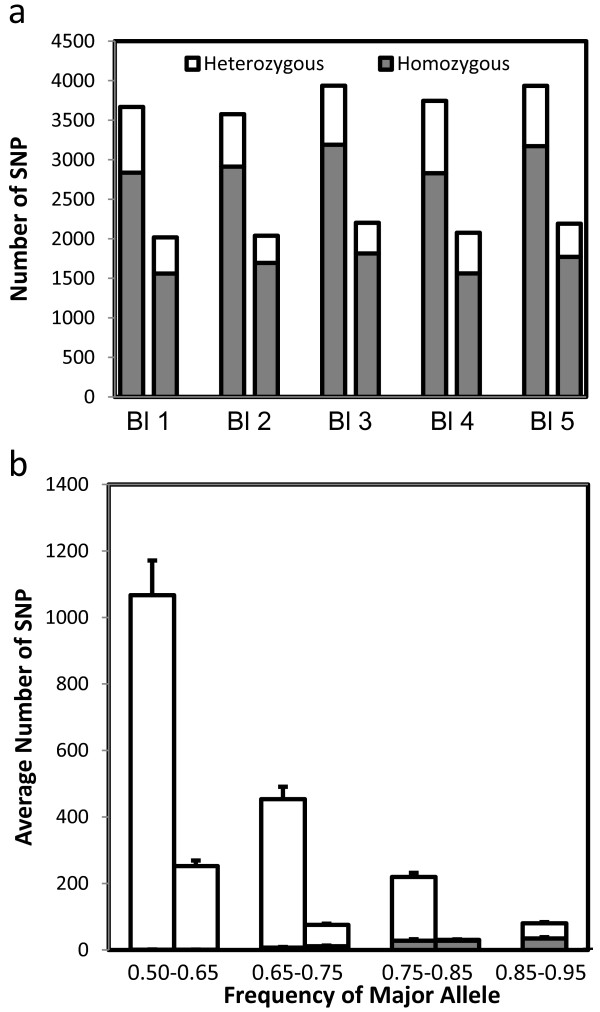
Allelic expression analysis in single bovine embryos. a) Number of SNP detected in each sample. Left bar indicates the total number of SNP detected. Right bar, represents the number of SNP that matched dbSNP variants by position. More than 99% of those matches agreed on nucleotide identity. b) Allelic bias in heterozygous SNP expression. Number of SNP expressed at different major allelic frequencies. Average number of validated (left bar) and putative (right bar) SNPs are presented separate. The number of SNP with statistically significant imbalance (FDR < 0.01 by X2 test) is indicated within their respective group (shaded area). The 85-95% frequency only includes validated SNPs.